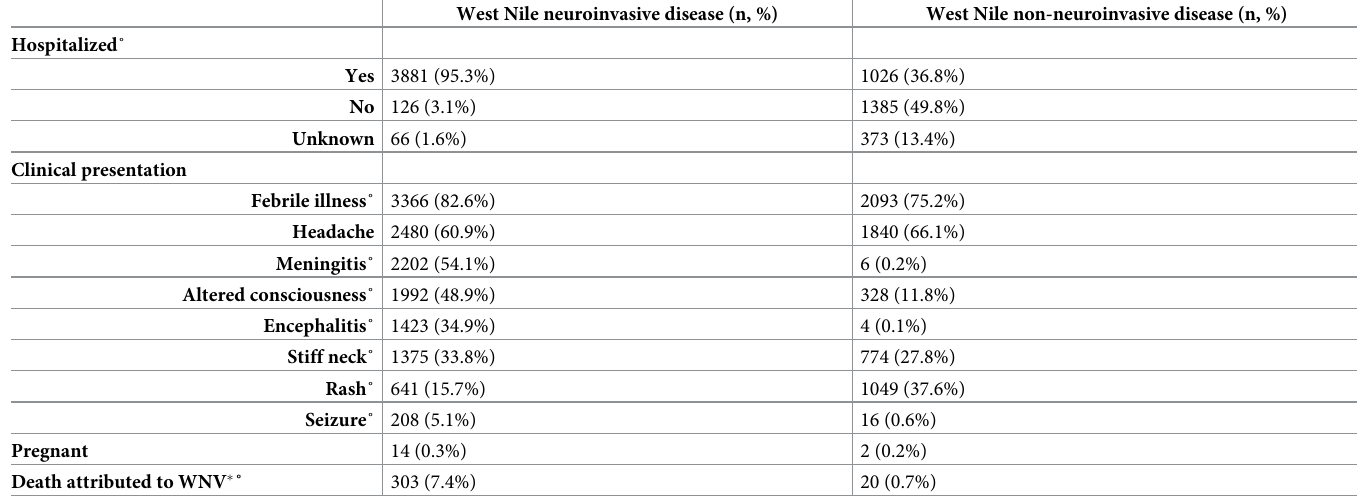
Table 2. Clinical characteristics of human West Nile neuroinvasive disease (n = 4,073) and non-neuroinvasive disease cases (n = 2,784) reported to the California Department of Public Health,